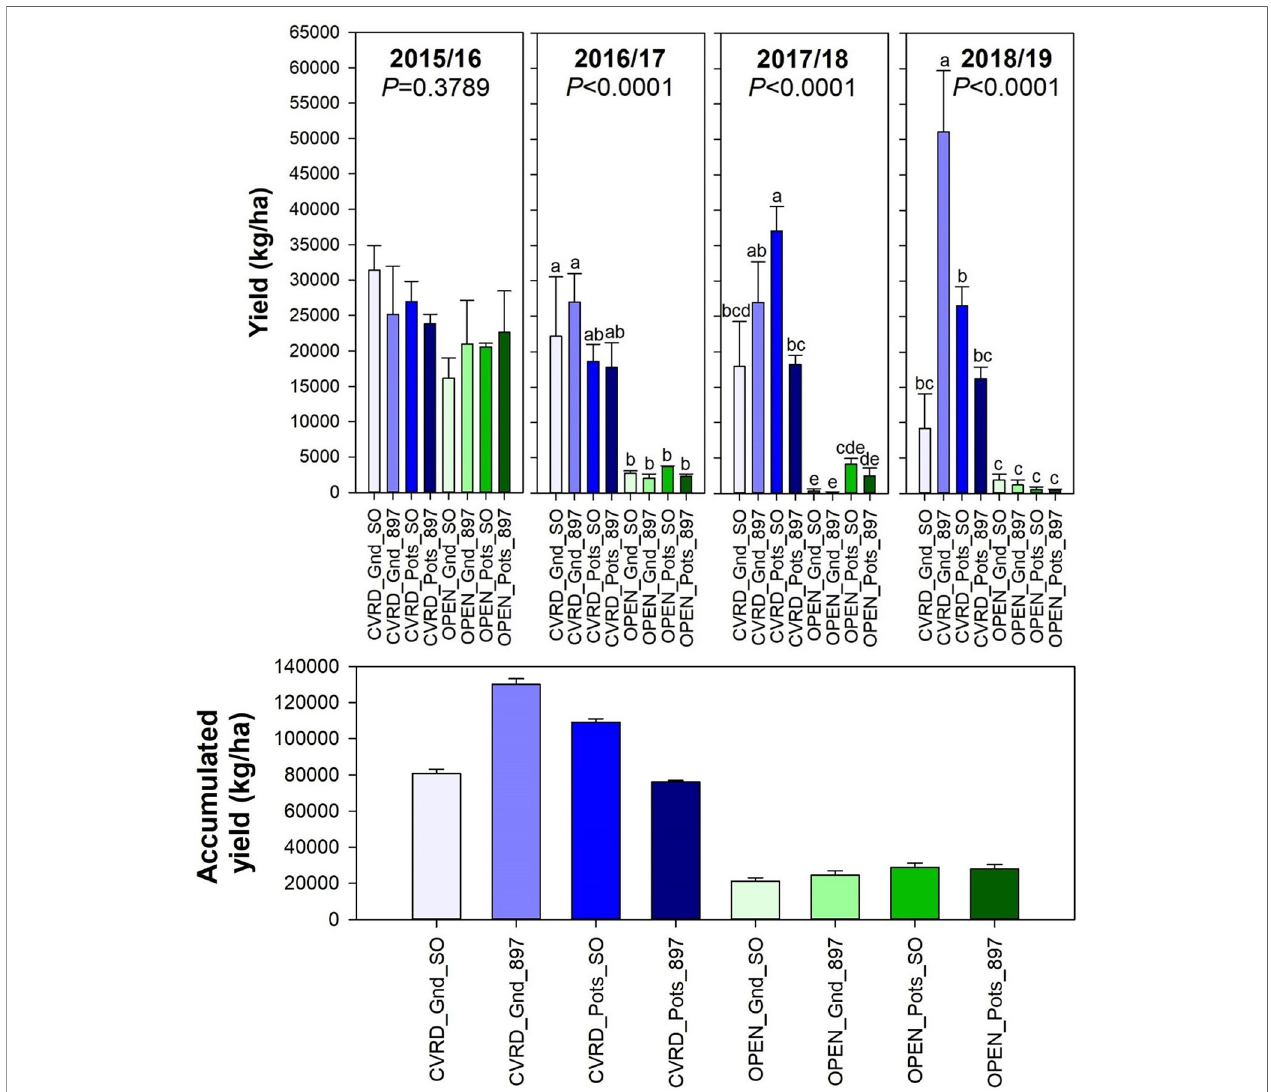
FIGURE 5 | Fruit yield of “ Ray Ruby ” grapefruit trees cultivated under two production systems (screenhouse, CVRD and open-air, OPEN), two planting systems (in- ground, GND and potted, POTS), and two rootstocks ( “ Sour Orange, ” SO, and “ US-897 ” ), with four replications arranged in a split-split-plot experimental design. Mean ± standard error of four replications. Means with the same letter are not signi fi cantly different from each other at 5% probability ( P ≤ 0.05) using Tukey mean comparison